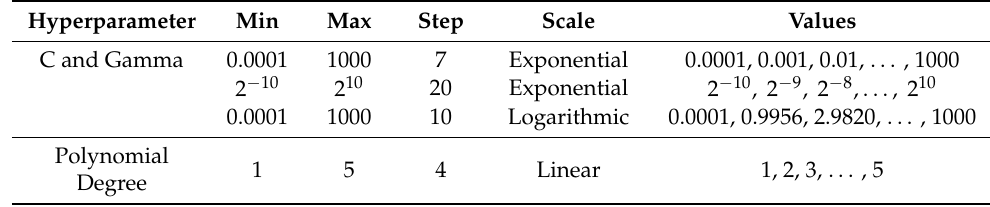
Table 8. Values of SVM hyperparameters in the grid